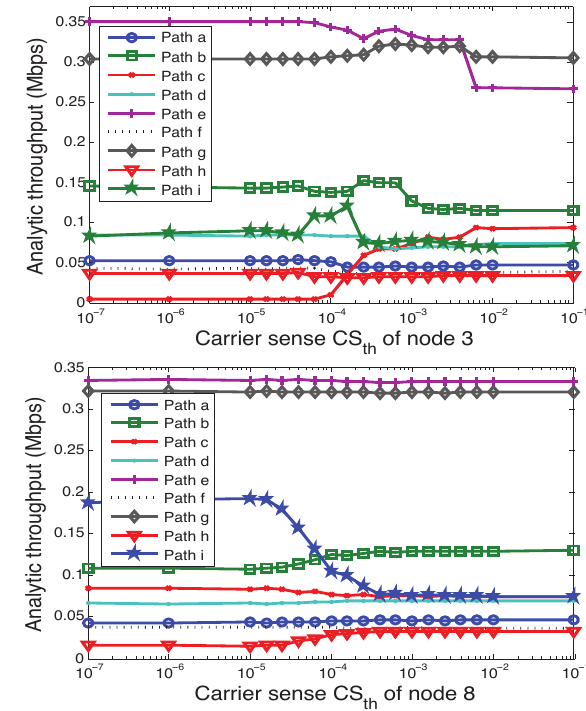
Figure 12. End-to-end throughput from model versus simulation for variable carrier sense threshold (in Watt).